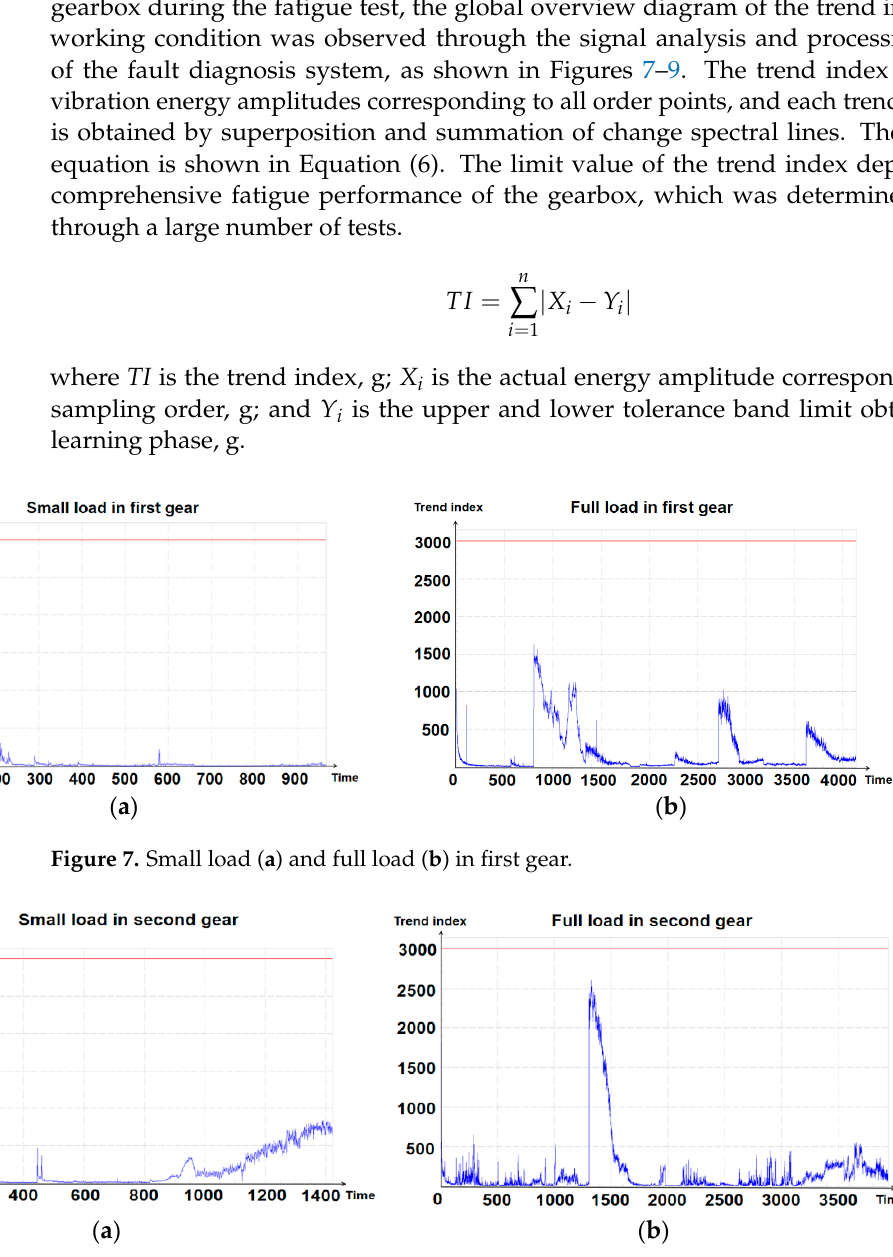
( b ) Figure 9. Small load ( a ) and full load ( b ) in third gear. Seeing Figures 7–9, the trend index curve of the fault diagnosis system exceeded the alarm limit under small load of third gear conditions, and the curve increased suddenly in many places at the same time. The trend curve increased obviously in the second gear low load condition, the second gear full load condition and the third gear full load condi- tion. The sudden rise and slow decline of the trend index curve for a full load may be related to the change of oil temperature in the gearbox. By analyzing the boundary condi- tions of the six data cards, the test conditions such as torque and rotational speed were stable and all within the learning range. Therefore, the increase of the trend index curve was not caused by the test conditions, which indicated that the internal mechanical struc- ture of the gearbox had changed. Because the first gear trend curve was basically stable and the monitoring stage was greatly affected by the oil temperature, the fault analysis was only carried out for the sec- ond and third gear working conditions. 3.2. Third Gear Fault Analysis Seeing Figure 10, according to the order calculation table of the differential steering gearbox, the order 200.25 in the figure was the meshing order of the third-gear master – slave gear, the meshing order of the power shunt gear and the tooth-embedded driving gear. The 167.5 order and 232.75 order in the diagram were the side frequencies of the meshing order, and the side frequency interval was 32.5, which was close to the third harmonic (35.342) of the shaft where the third-gear driven gear and power shunt gear were located. Therefore, the fault may occur on these two gears. Simultaneously, the order of the side frequency band was less, the distribution was more concentrated and the am- plitude was higher, which was the typical characteristic of distributed fault pitting fatigue failure.